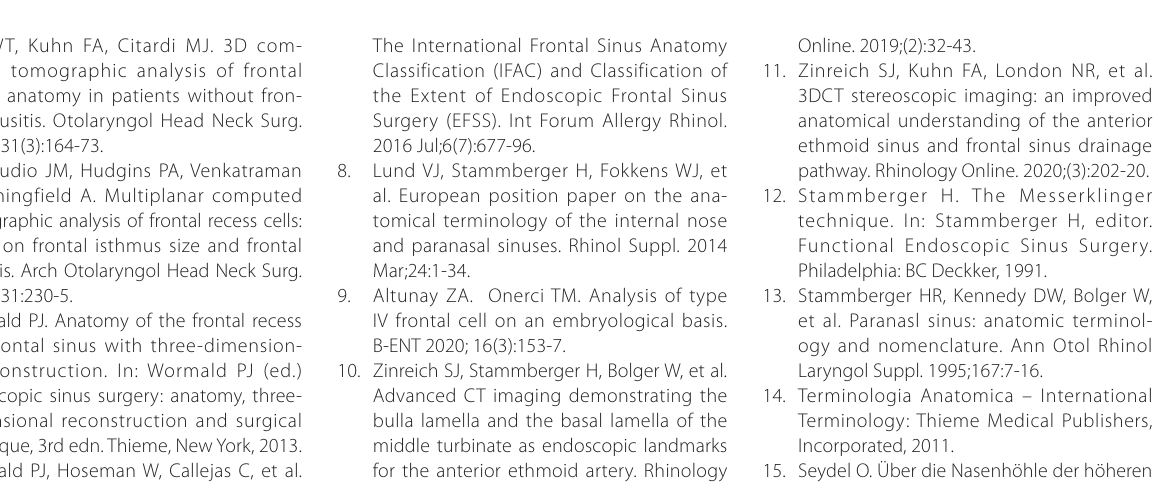
Figure 7. The pronounced inferior/anterior/medial/lateral expanding FSRS. B.1 The inferior expanding FSRS through opening in roof of IS-EUP. a.- c. 3D sagittal images (right side) shown sequentially from medial to lateral, reveal the inferior extension of the FSRS (FSRS, green outline), through a large opening in the roof of the EUP (red arrow) with direct communication with the IS-EUP reaching the superior turbinal uncinate process (TUP, black arrow). Note the superior uncinate reaching the skull base, is the anterior border of an Inter-Lamellar Space (ILS) bordered posteriorly by the Bulla Lamella (blue outline), and communicating inferiorly with the Middle Meatus (yellow arrow). Common Lamella (red outline). B.2 Examples of inferior expanding FSRS displacing, without invading the IS-EUP roof. a. 3D sagittal image (left side) shows the prominent inferior extension of the FSRS to the superior TUP, with posterior displacement of the IS-EUP (gold outline). Note the direct communication of the FSRS to the EI (red arrow). Bulla Lamella (blue outline). b. and c. Different patients (left side) with the FSRS (green outline extending inferiorly to the level of the superior TUP, with inferolateral displacement of the IS-EUP (gold outline). Note the lateral direct communication with the EI (red arrows). Yellow asterisk: interlamellar